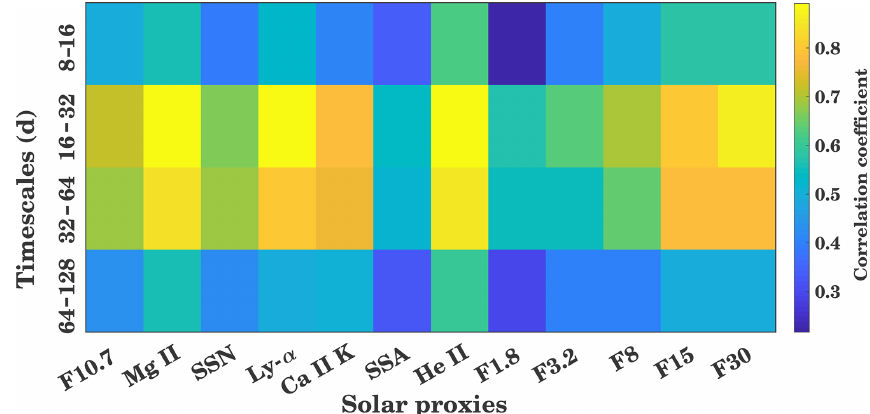
Figure A1. Wavelet cross-correlation sequence estimates for the maximal overlap discrete wavelet transform for GTEC and multiple solar proxies for different timescales (8 to 16, 16 to 32, 32 to 64, and 64 to 128d). The colors represent the correlation coefficient at lag 0.